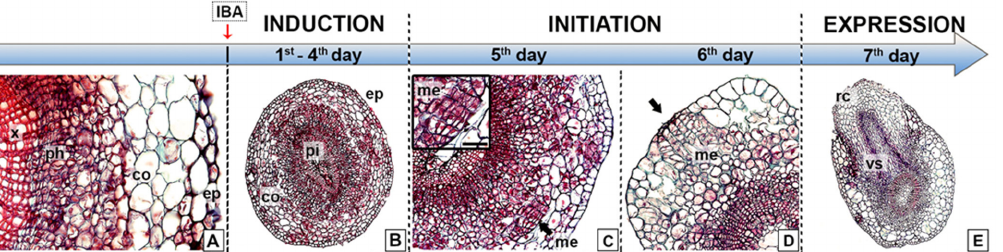
Figure 2. Ontogeny of in vitro root formation in juvenile shoots of E. nitens . ( A ) Transversal section of the basal stem, displaying a typical anatomical structure; ( B ) transversal section of the rooting zone after four days from the IBA treatment; ( C ) cell divisions nearest the periphery of cortical parenchyma; ( D ) small meristematic cells group leading root meristem formation; and ( E ) root emergence through the stem epidermis. Ref. co, cortex; ep, epidermis; me, meristemoids; ph, phloem; pi, pith; rc, root cap; x, xylem; vs, vascular system. Bars indicate 20 µ m ( A ), 50 µ m ( C ), 100 µ m ( D ), and 200 µ m ( E ).